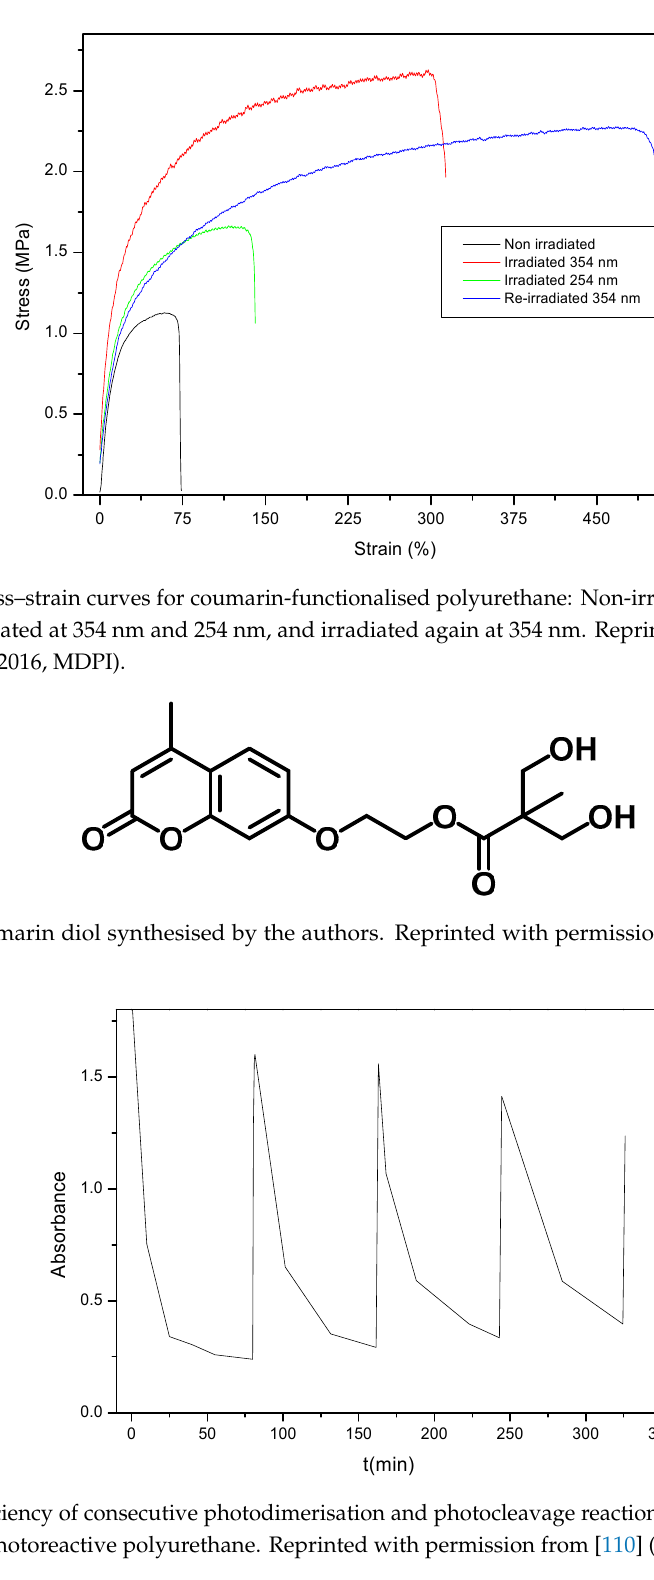
Figure 3. Efficiency of consecutive photodimerisation and photocleavage reactions from absorbance at 319 nm of a photoreactive polyurethane. Reprinted with permission from [110] (©2016, Elsevier). Salgado et al. analysed the influence of the molecular weight of poly( ε -caprolactone) as soft segments on the performance of photoreactive polyurethanes based on the same coumarin diol [111]. A similar procedure developed by Seoane et al. [110] was carried out to synthesise the dihydroxyl coumarin. However, a coumarin- and HDI-based polyurethane prepolymer was produced before further reaction with PCL-diols (Mn = 530 and 2000 g·mol − 1 ). The analysed coumarin concentrations were 5 mol%, 15 mol% and 25 mol% for evaluating the different content of hard segment. The polyurethanes were characterised by the presence of both mono- and bi-substituted coumarin diol. The content of monosubstituted specie increased with the coumarin content (evaluated by 1 H NMR and ATR-FTIR). Furthermore, the procedure based on the prepolymer seemed to promote bi-substituted species in the structure, as well as higher molecular weights with lower polydispersity when compared to previous authors’ work [110]. 0